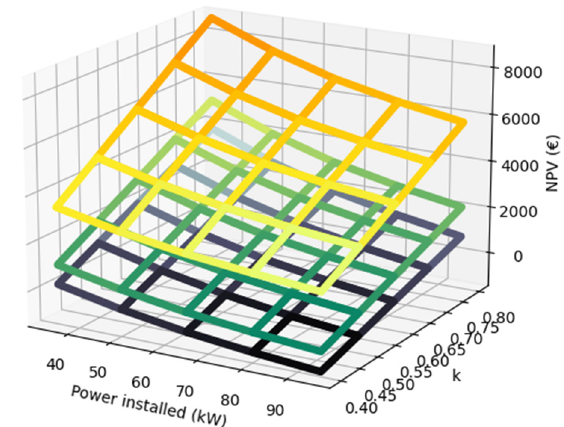
Figure 7. Applicant NPV as a function of the installed power and k. Dark blue surface obtained for market prices from 2020, green surface for 2019 and yellow surface from 2021 .